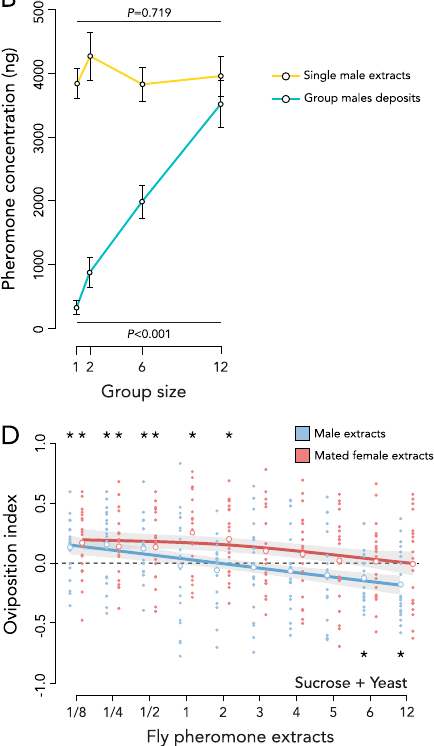
n =6 for 6 fl ies and n =8 for 12 fl ies). C Oviposition preference to pheromone extracts of increasing numbers of males (blue) or mated females (red) on ovipo- sition zones containing 100mM sucrose (see methods). D Oviposition preference on oviposition zones containing 100mM sucrose and 8.75g/L of yeast. The indi- vidual replicates are visualized by the small data points and the mean oviposition indicesaregivenbylargerun fi lleddatapoints.Thesedatapointsareanalyzedusing two-tailed Wilcoxon signed rank tests. The non-linear analysis ( fi tted with GAM) in C andlinearanalysis( fi ttedwithGLM)in D arevisualizedwiththeir95%con fi dence intervals (gray shaded area). The asterisks above or belowatreatment respectively indicate attraction or aversion differing signi fi cantly from zero (0.0 dashed line